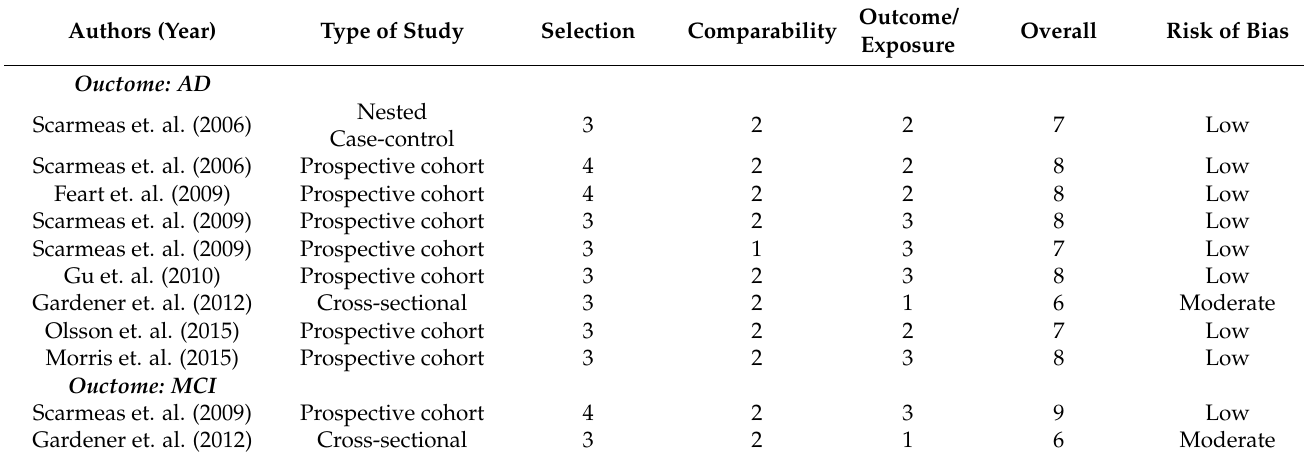
Table A1. Risk of bias of the included studies using the Newcastle-Ottawa scale.